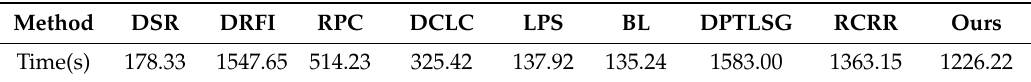
Table 5. Running time comparisons for nine methods.